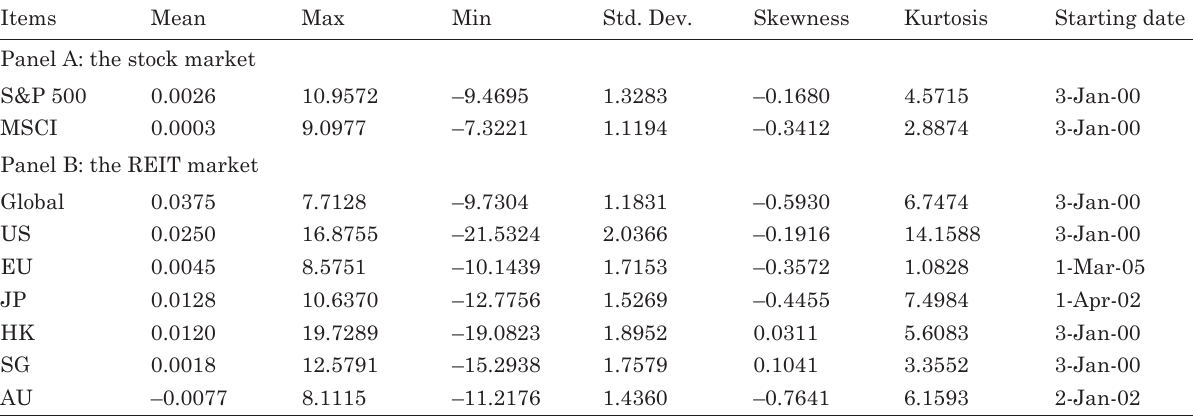
Table 1. Descriptive statistics on stock returns and REIT returns